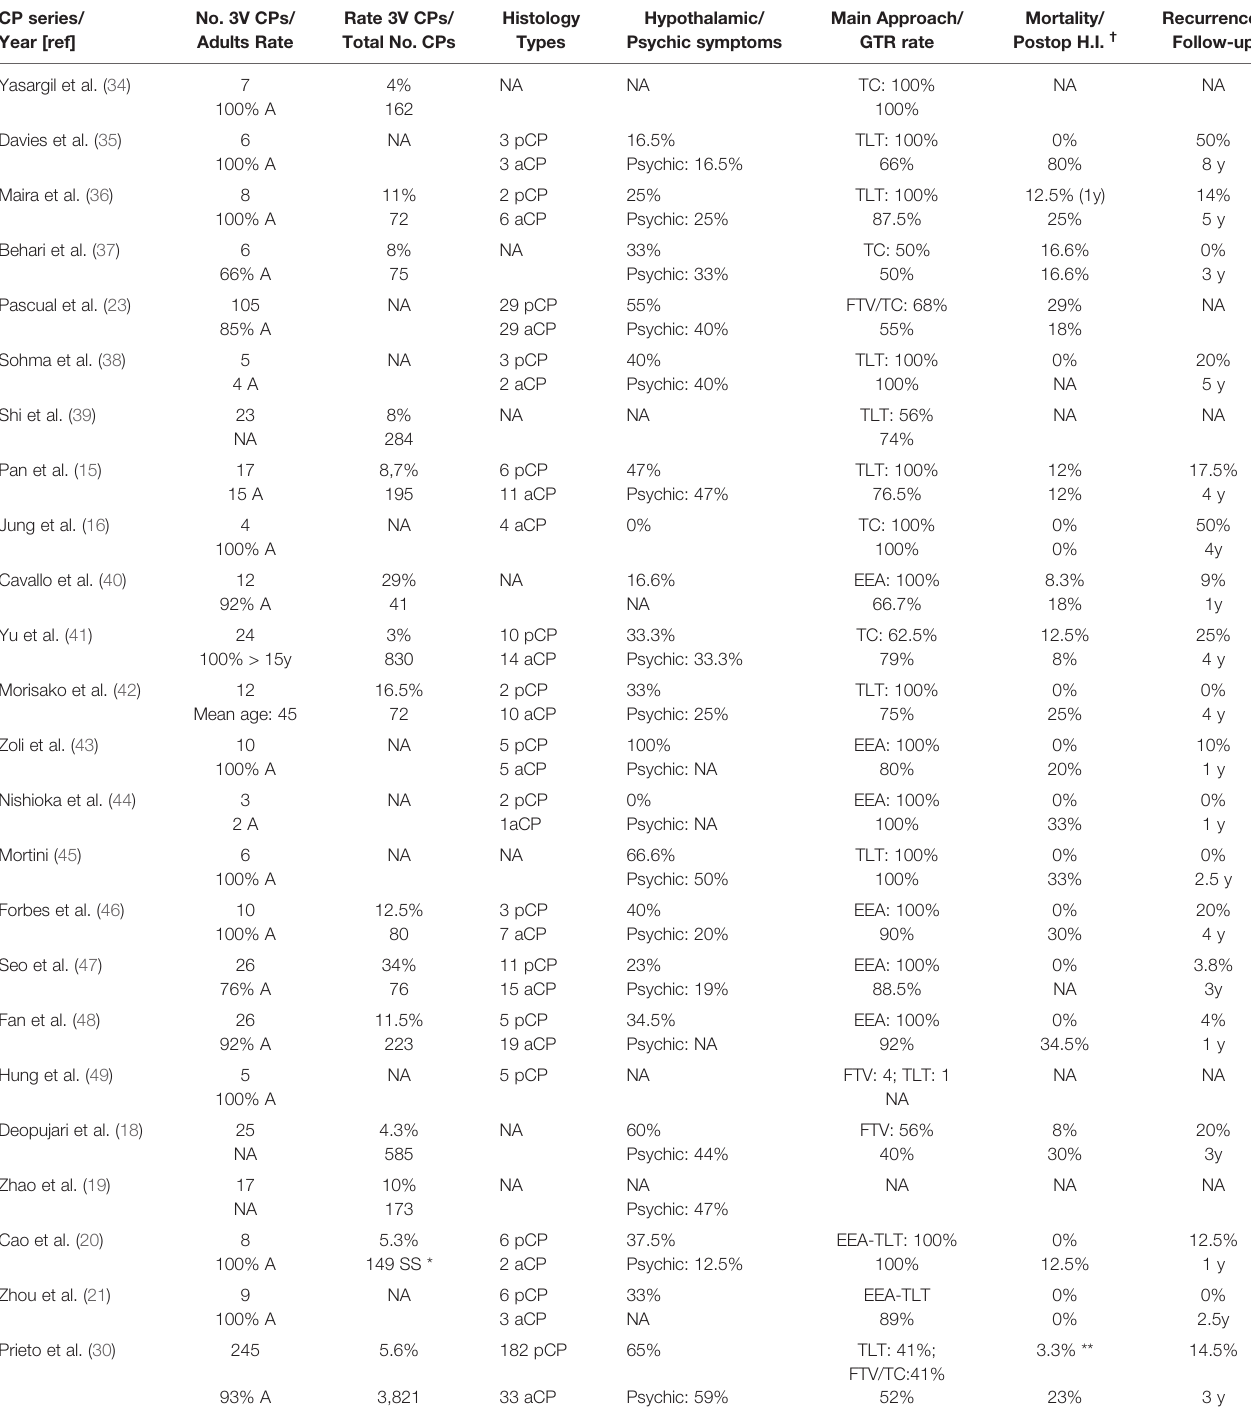
TABLE 1 | Epidemiological, clinico-pathological and surgical characterization of third ventricle craniopharyngiomas (3V CPs) included in modern CP surgical series. CP series/ Year